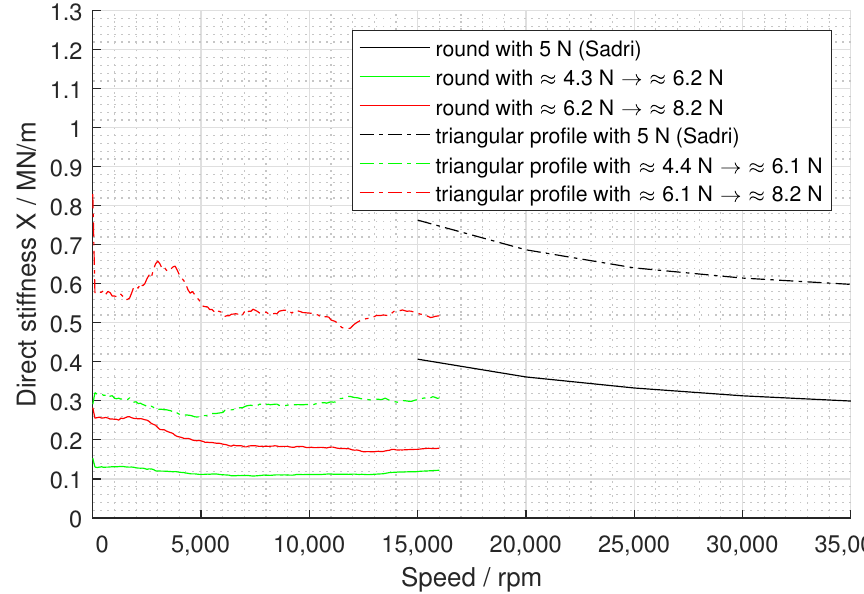
Figure 11. Calculated stiffness from Figure 10 and results of Sadri